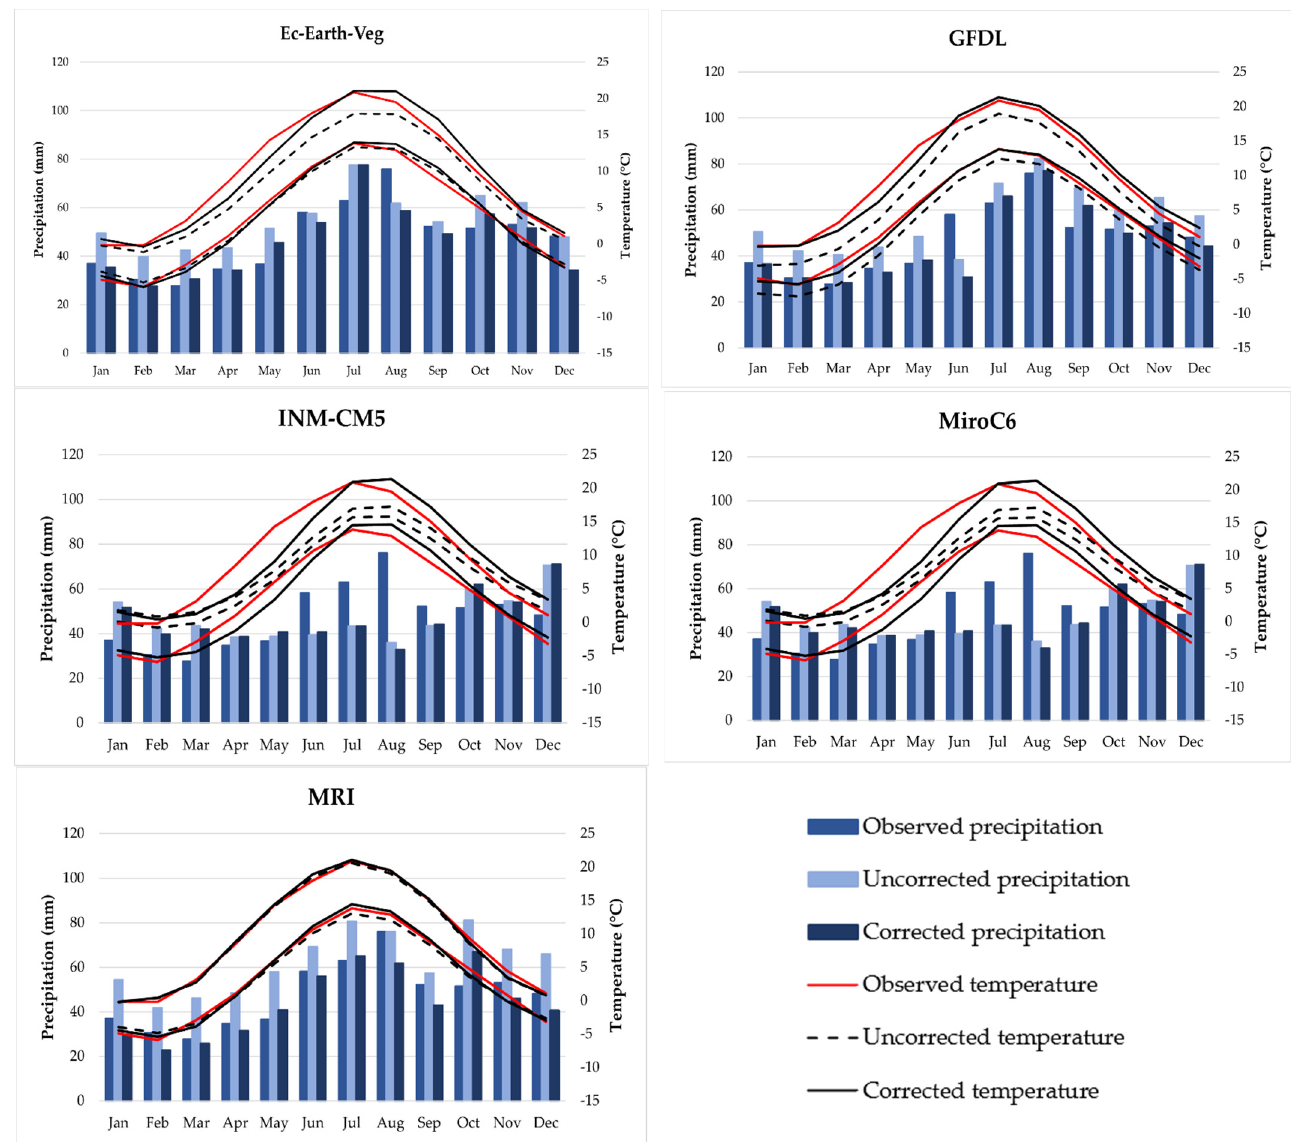
Figure 4. Comparison of bias-corrected baseline data of each GCM compared with observed monthly average precipitation, maximum and minimum temperature in the Lake Erken basin in the historical period (1985–2014).